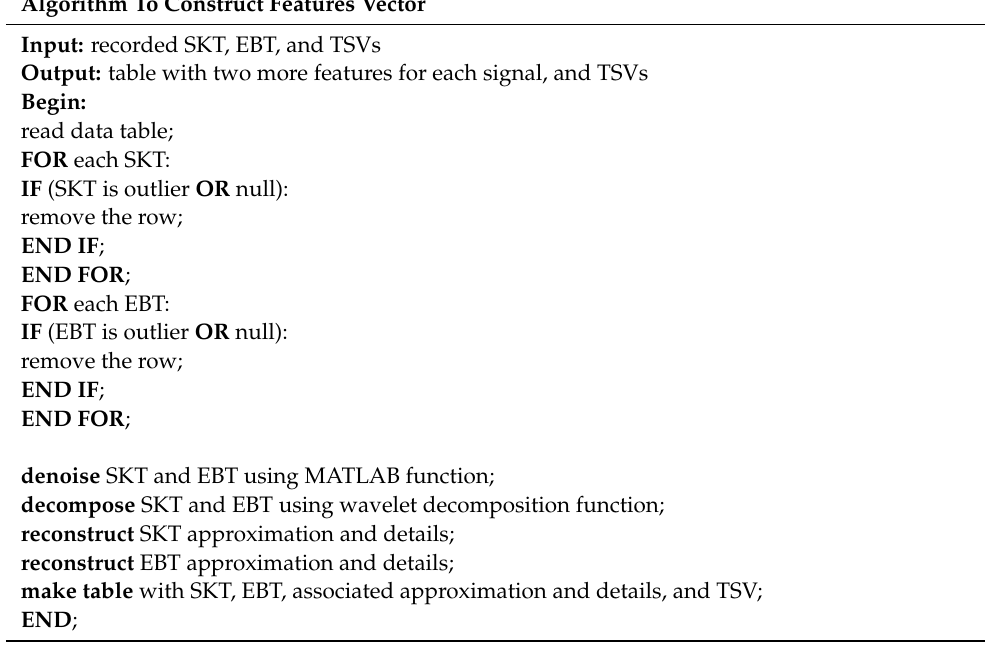
Algorithm 1: Pseudo-code for wavelet-based feature creation Algorithm To Construct Features